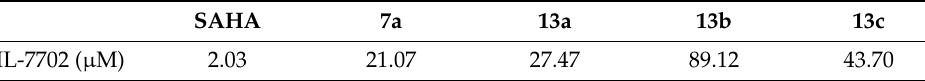
Table 3. Cytotoxicity of 4 preferred compounds on HL-7702.